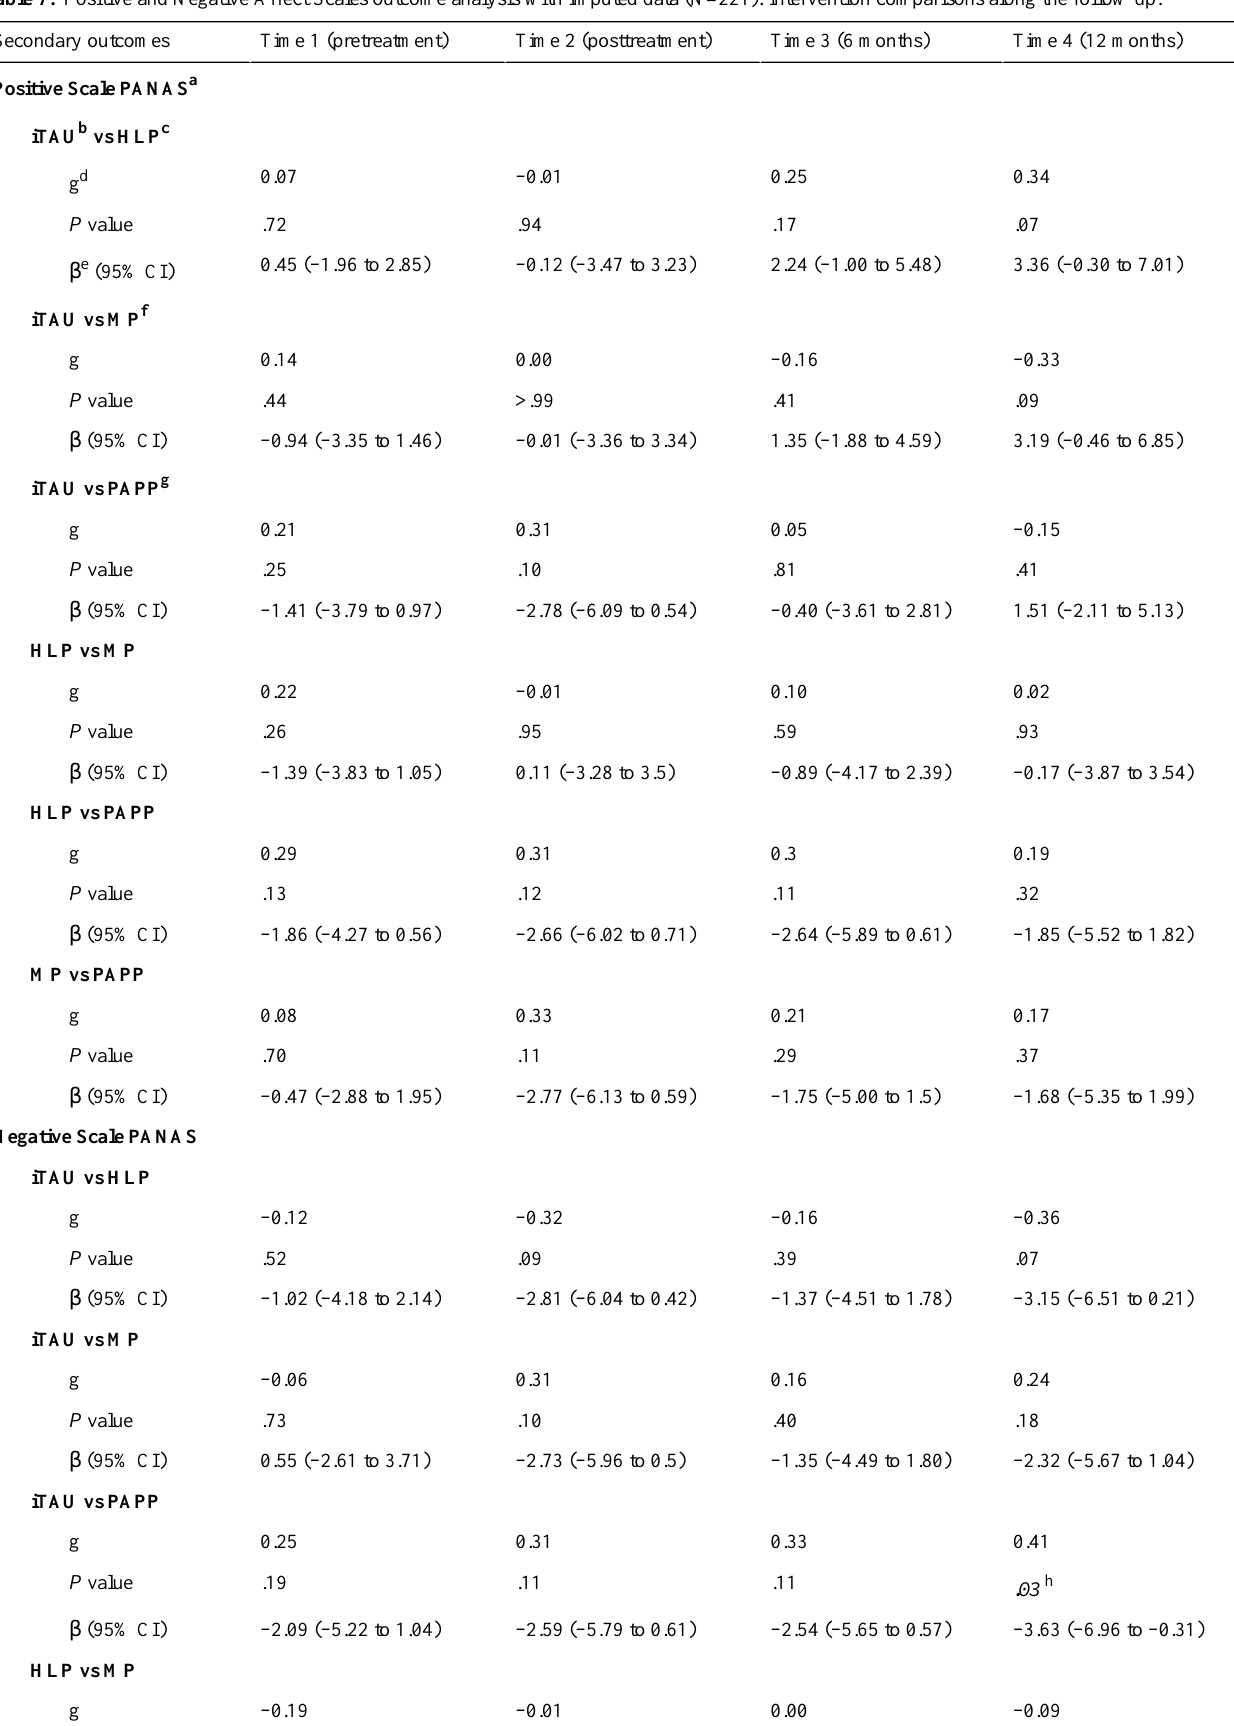
Table 7. Positive and Negative Affect Scales outcome analysis with imputed data (N=221): intervention comparisons along the